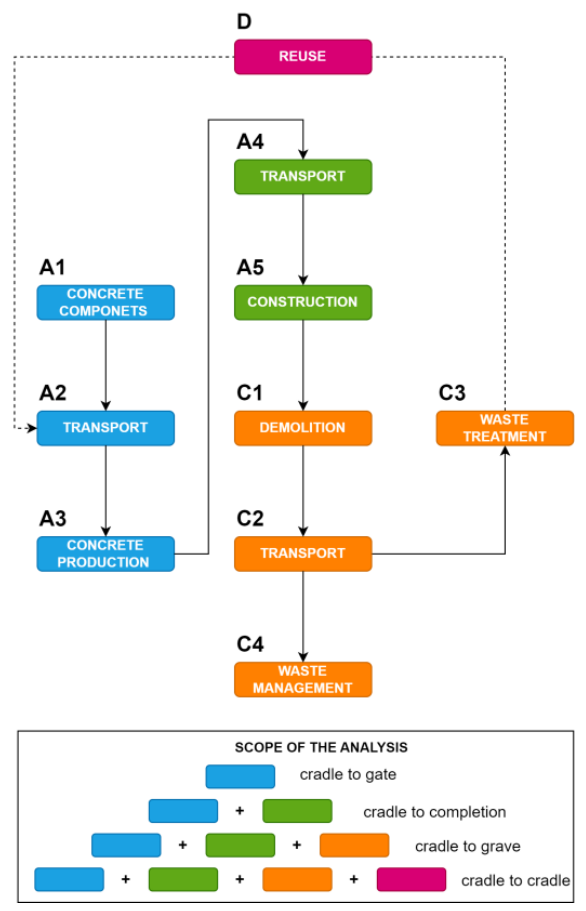
Figure 2. Life cycle of concrete. Own elaboration based on [14,15].